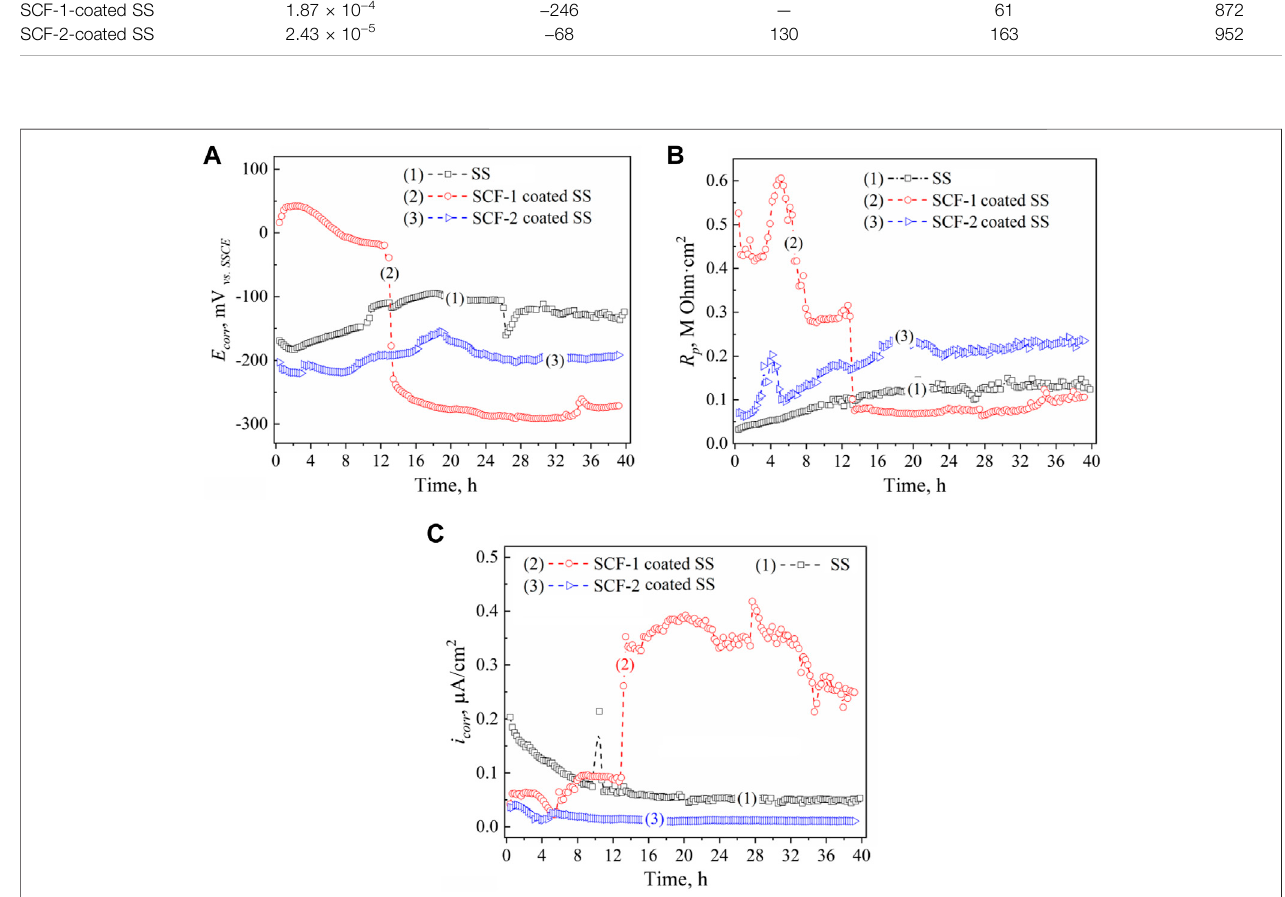
FIGURE 10 | LPR results of the BG-ESM-PCL composite coatings in SBF solution: E corr (A) , R p (B) , and i corr (C) kinetics. Kinetics: (1) uncoated SS, (2) SCF-1- coated SS, and (3) SCF-2-coated SS, respectively.